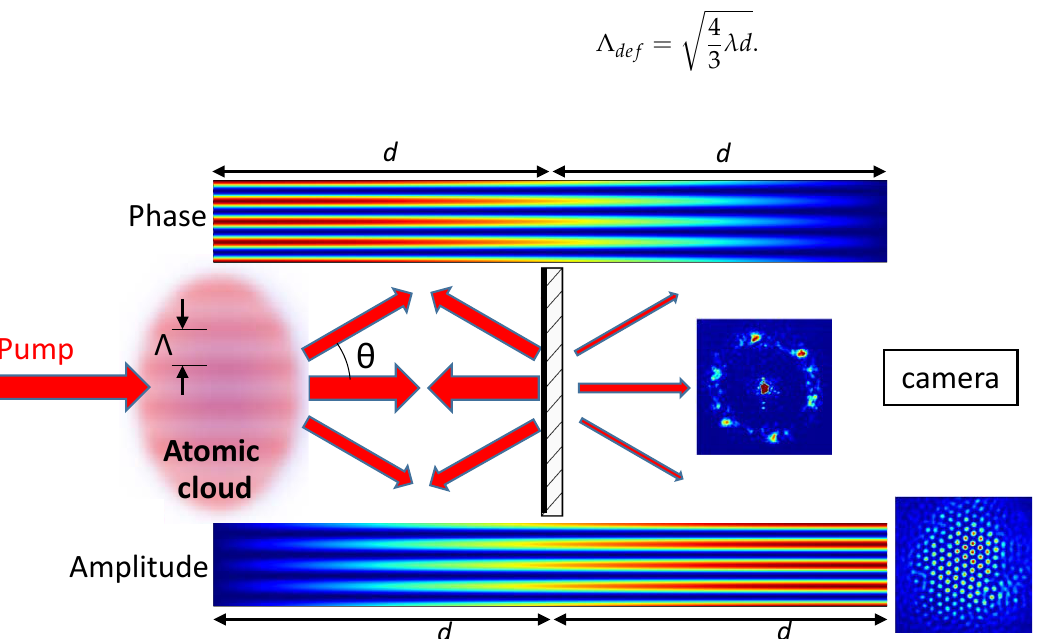
Figure 1. Scheme of feedback experiment: A coherent pump beam drives an atomic cloud of size L with a plane feedback mirror at a distance d . Pump photons are scattered by a spatial structure with period Λ in the cloud into sidebands at an angle θ . Interference of these sidebands forms an optical lattice sustaining the spatial structure in the cloud. The sidebands can be visualized by looking at the far field of the transmitted light as obtained in the focal plane of a lens. The inset shows an example for an experimentally observed far field (FF) intensity distribution showing transverse Fourier space (displayed span − 8.5 to 8.5 mrad around optical axis). The upper panel illustrate how the phase modulation arising after the cloud is diminishing during propagation whereas an amplitude modulation (lower panel) builds up by diffractive dephasing. At a distance 2 d the amplitude modulation is fully developed and the phase is flat. Here, the transmitted light has the same spatial structure as the retro-reflected feedback beam re-entering the atomic cloud. This near field (NF) intensity distribution can be imaged onto a camera (example shown in lower right inset, displayed range 2 mm). Parameters for images: input intensity 129 mW/cm 2 , detuning ∆ = 7 Γ , saturation parameter s ≈ 0.18, dominantly optomechanical